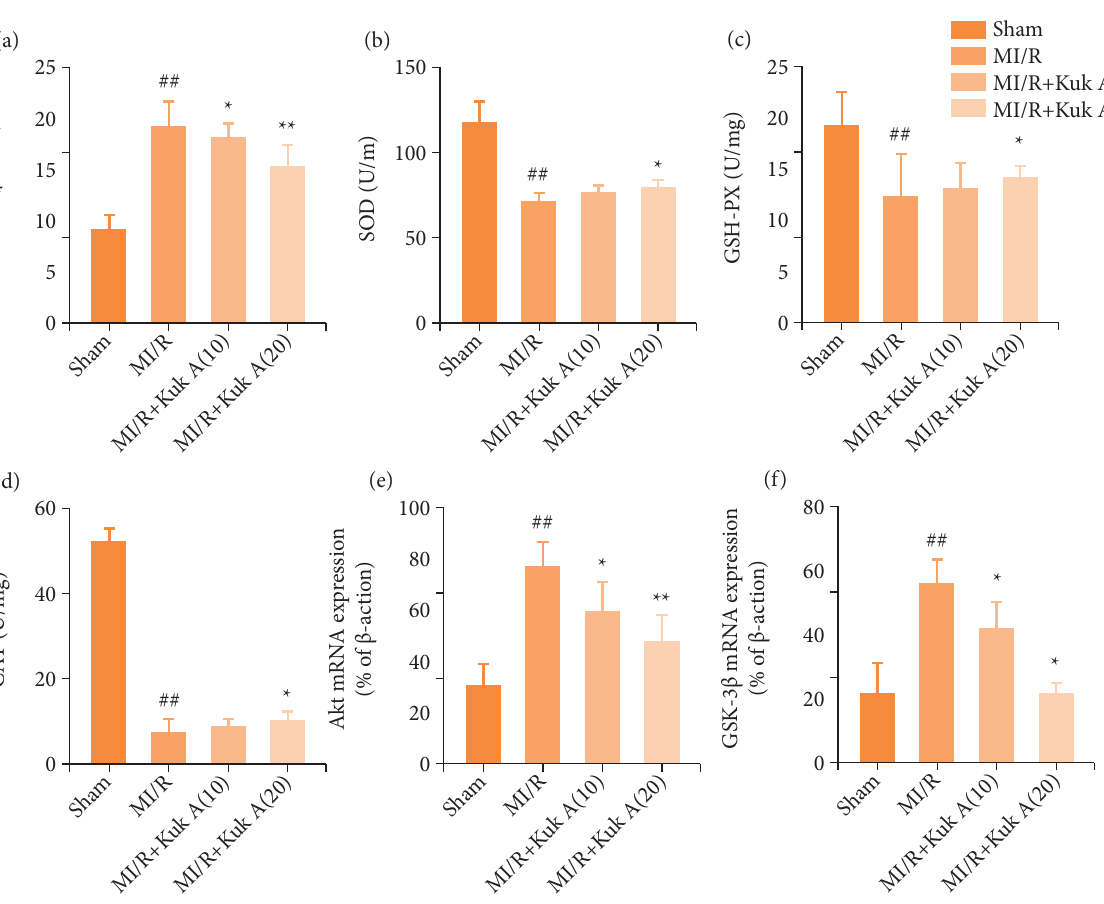
Figure 2 - Effect of KukA on oxidative stress and Akt/GSK-3 β after MI/R treatment in